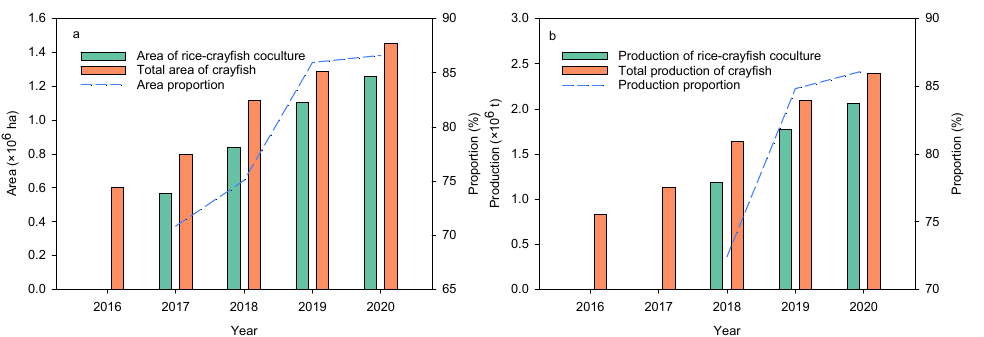
Figure 6. The red swamp crayfish area ( a ) and production ( b ) in the rice–crayfish coculture system and total crayfish aquaculture system in China [1].